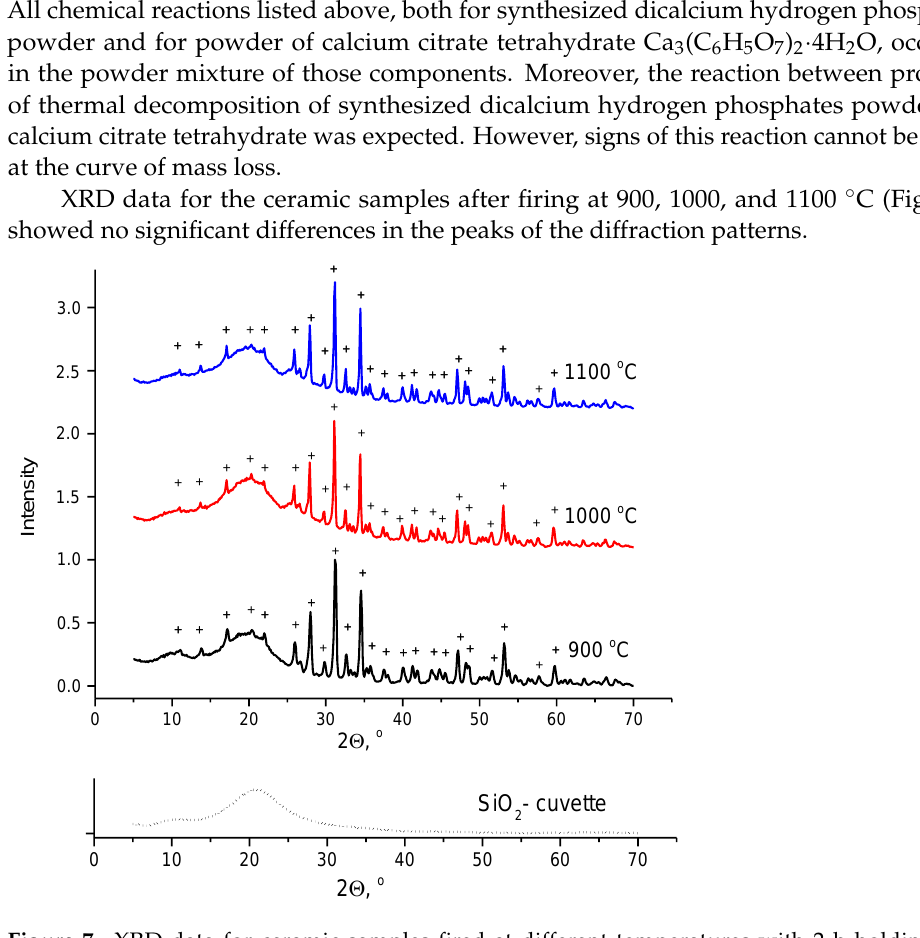
Table 1. Comparison of mass spectra data for synthesized powder, calcium citrate tetrahydrate Ca 3 (C 6 H 5 O 7 ) 2 ·4H 2 O, and their powder mixture.